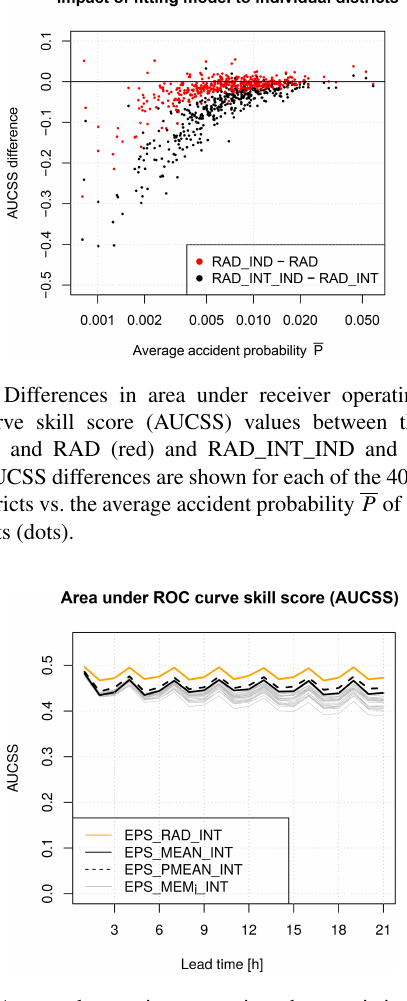
Figure 4. Area under receiver operating characteristic curve skill score (AUCSS) values of different models for hourly probabili- ties of weather-related road accidents using radar, reanalysis and weather forecast data from 2011 to 2012 as a function of lead